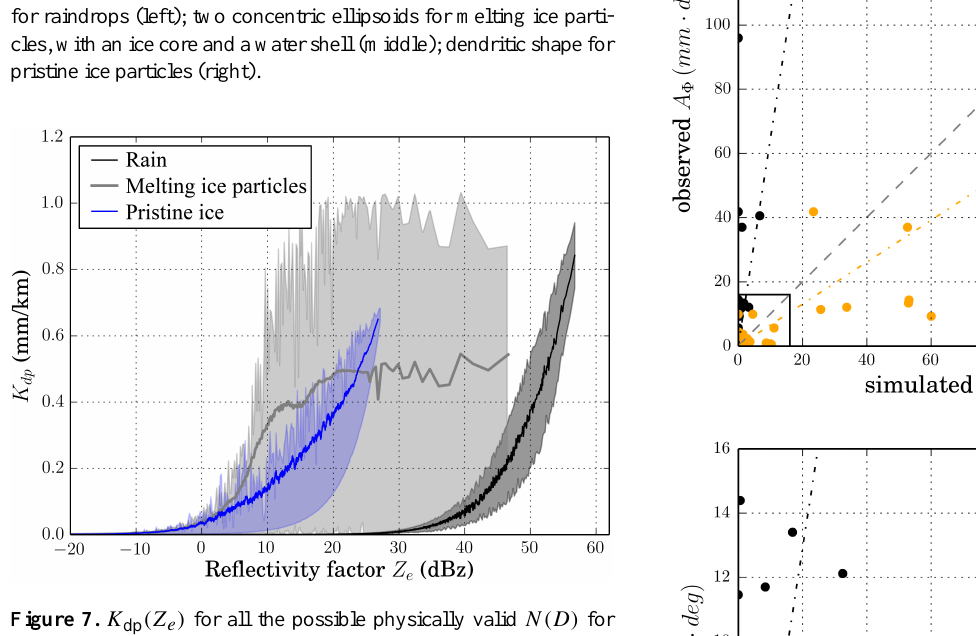
Figure 7. K dp (Z e ) for all the possible physically valid N(D) for each hydrometeor type: rain (black), melting ice particles (grey) and ice crystals (blue). Raindrops need high reflectivity to produce high K dp , while ice crystals and melting ice particles can induce high values of K dp at smaller values of Z e . The thick lines overplotted represent the Z e − K dp relation used in this analysis for each hy- drometeor type.